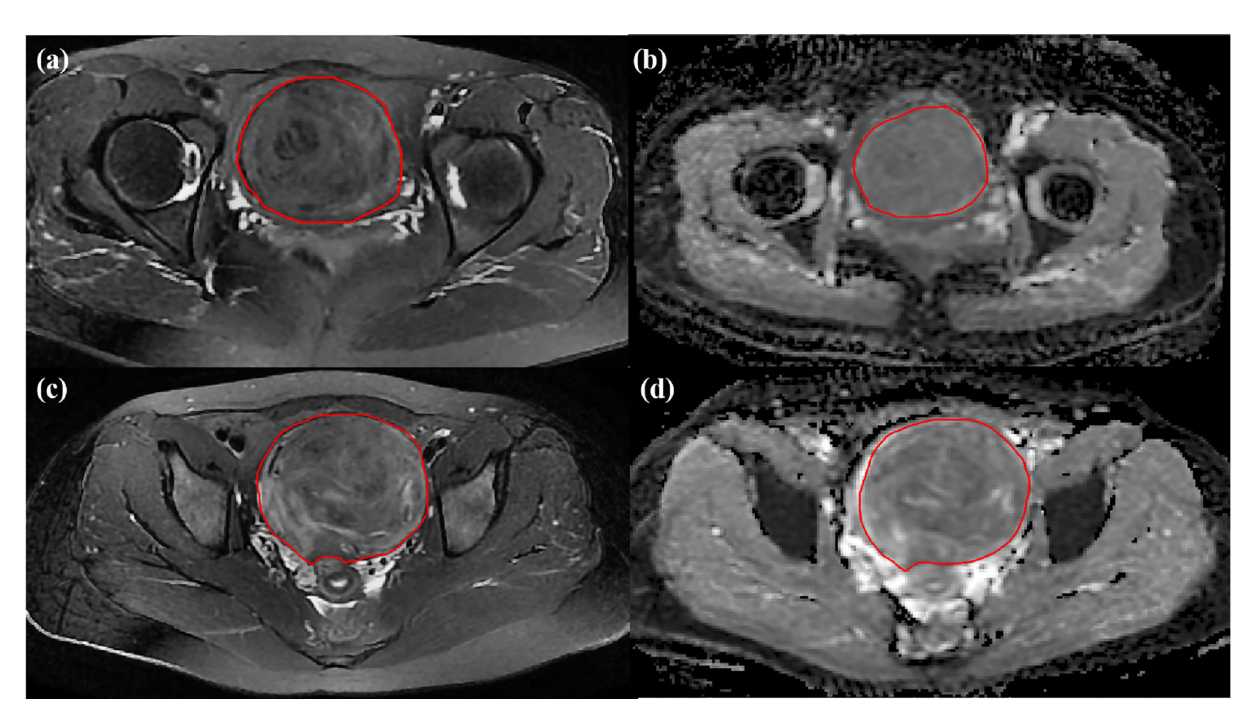
FIGURE 3 | Two cases for delineating ROI. The preoperative MR images for uterine leiomyomas with suf fi cient ablation on (A) T2WI image and (B) ADC map from DWI and with nonsuf fi cient ablation on (C) T2WI image and (D) ADC map from